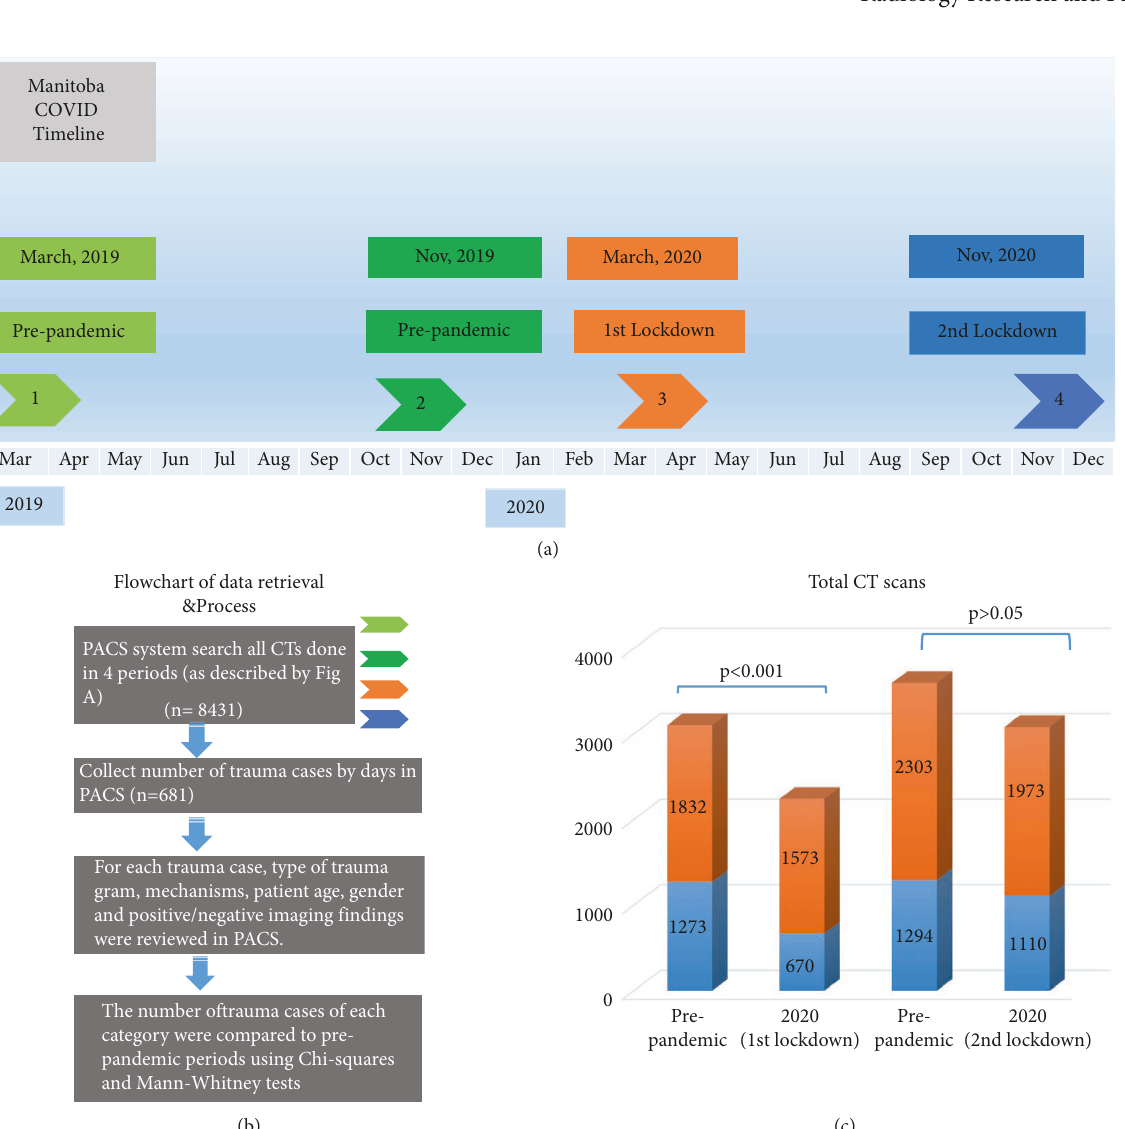
Figure 1: (a) Timeline of the COVID-19 Pandemic in Manitoba. Period 1: a prepandemic month in 2019 (March); Period 2: a prepandemic month in 2019 (Nov); Period 3: a 1-month period during the 1st COVID-19 lockdown period in 2020(March); Period 4: A 1-month period during the 2nd lockdown in 2020 (Nov) (Figure 1(a)). We matched the same month during prepandemic control due to a known seasonal variability on CT volume (winter road conditions, ice, and snow). (b) The flowchart depicting the process of a total of 962 trauma patients selected in our study. The demographics and subtypes of scans were collected via the PACS system. (c) The comparison of total elective CT scans and STAT CTcases including emergency and inpatient cases in our level 1 trauma center during two COVID-19 lockdown periods in 2020 and corresponding prepandemic periods in 2019, was made using χ 2 test (Chi-square analysis). p value refers to a relative portion of STAT cases to total CT